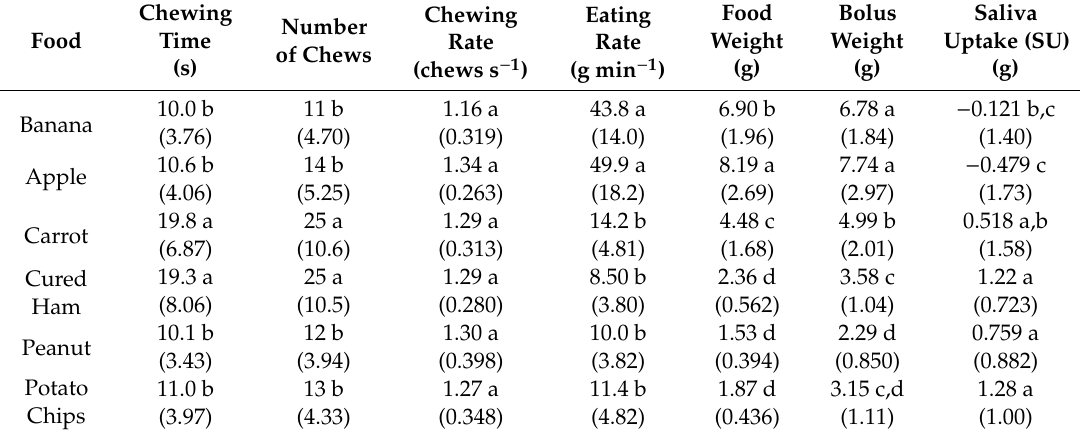
Table 5. Mean oral processing behavior and bolus saliva uptake of 39 healthy participants for the selected